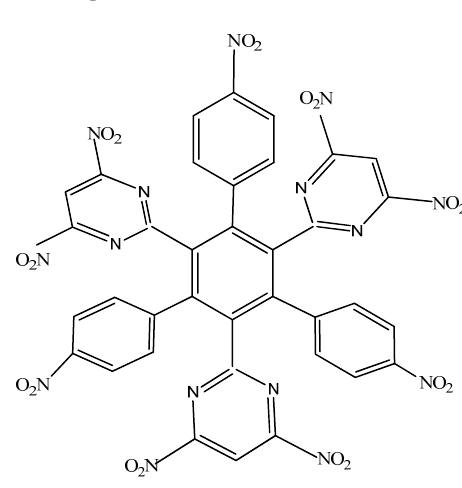
Figure 4. Structure of HAB2